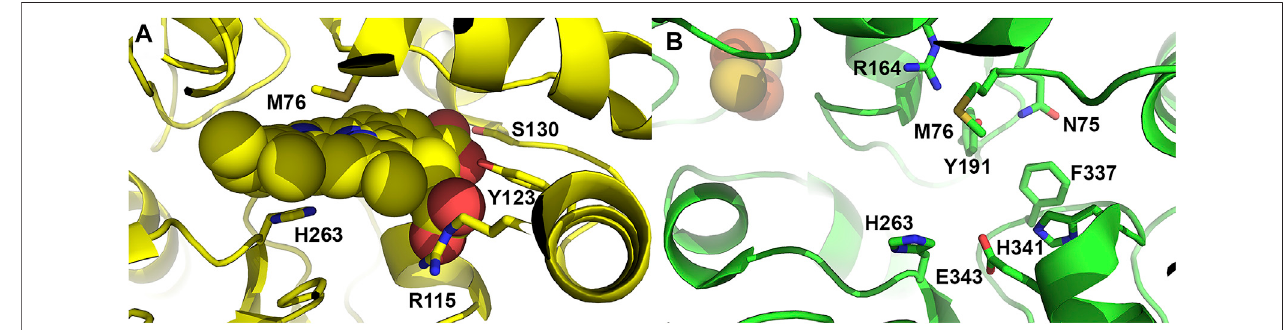
FIGURE 4 | Active site residues of ferrochelatase. (A) Cartoon representation of the human ferrochelatase active site with protoporphyrin IX bound, shown as spheres, in the closed conformation. Key residues which interact with the porphyrin substrate and participate in catalysis are shown as sticks and labeled. (B) Cartoon representationofhumanferrochelatasewithkeyresidueswhichparticipateinthehydrogenbondingnetworkatthetopandbottomoftheactivesiteshownassticksand labelled. Created using PyMOL Molecular Graphics System (Schrodinger, LLC), PDB ID 2HRC (A) and PDB ID 2QD1 (B)